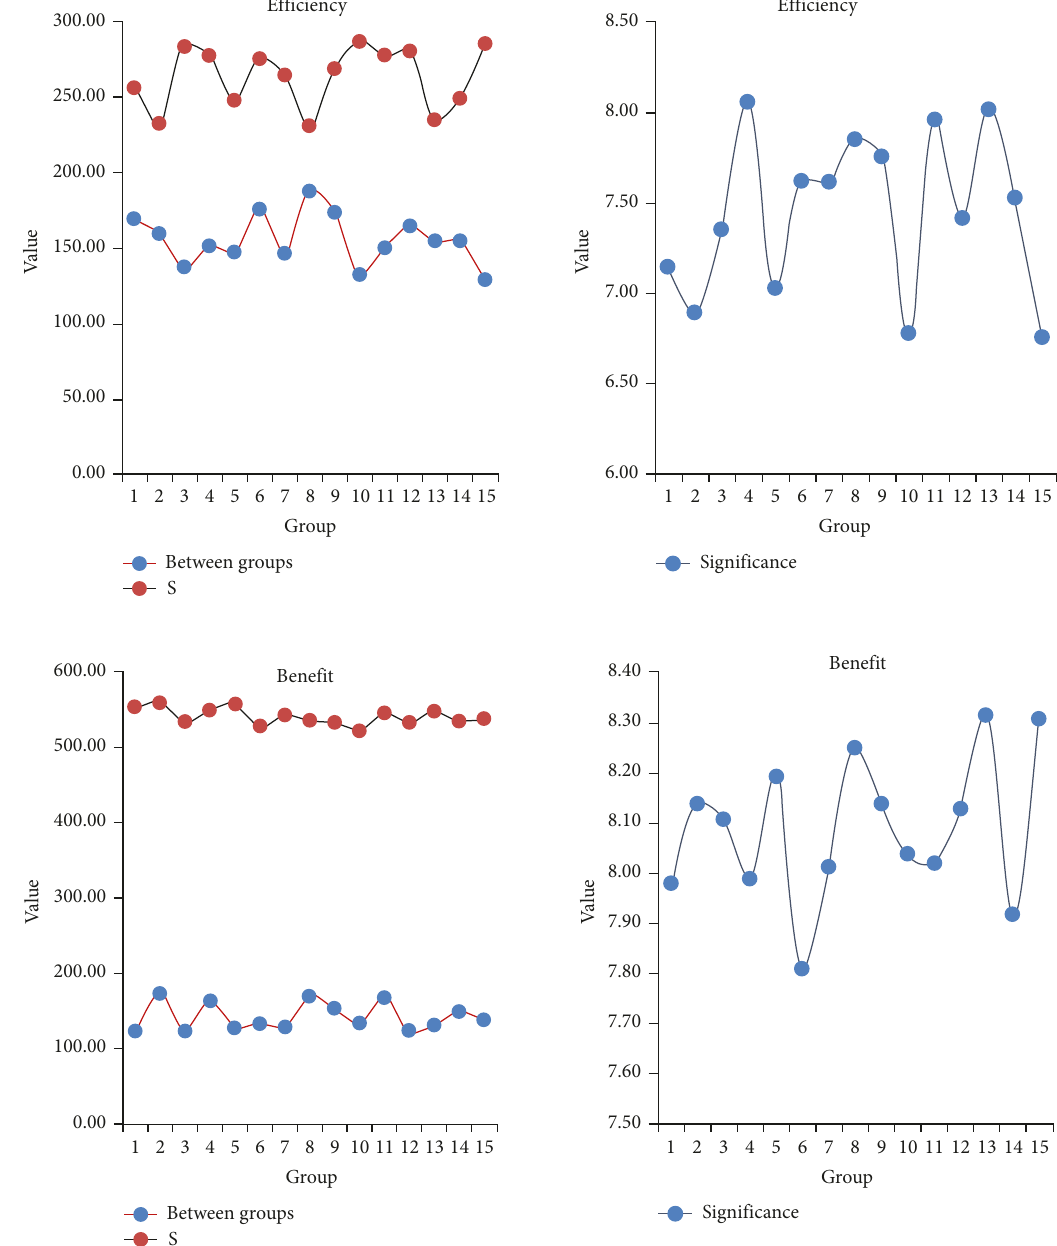
Figure 8: Smart manufacturing benefits and smart manufacturing